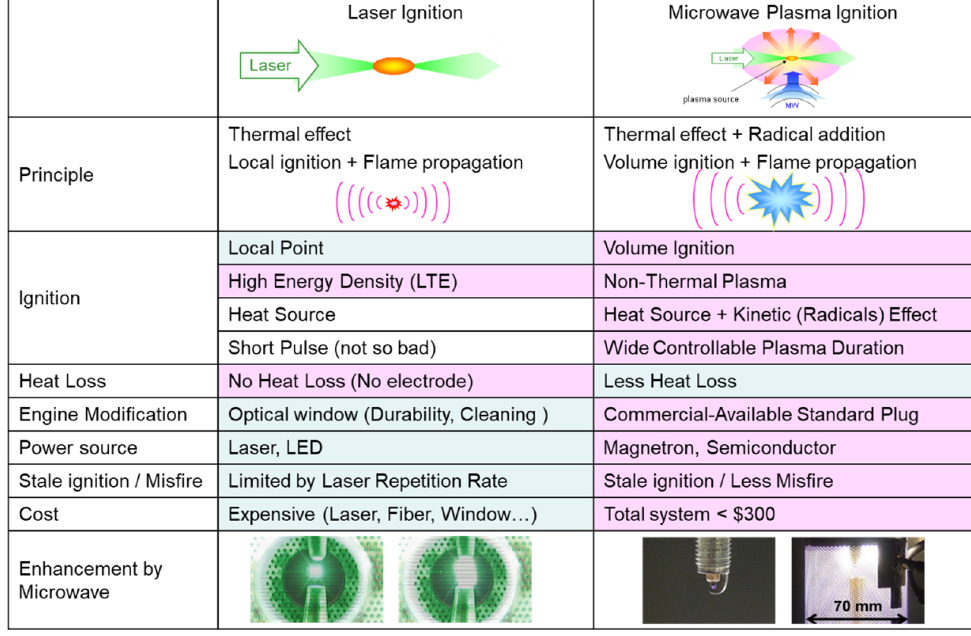
Figure 3. Laser ignition compared with microwave plasma